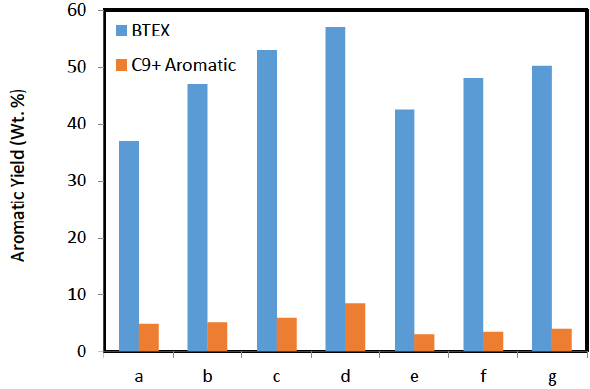
Figure 5: Aromatic Yield: a. HNZ5, b. Ga1.5-NZ5, c. Ga2.1-NZ5, d. Ga4.2-NZ5, e. Ga1.5/NZ5, f. Ga2.1/NZ5, g. Ga4.2/NZ5